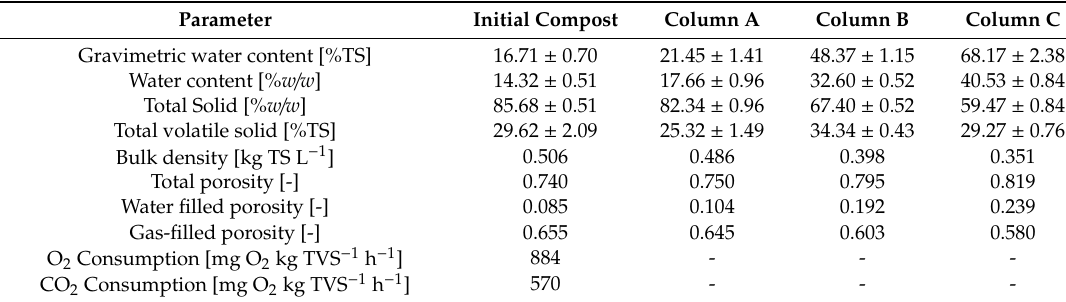
Table 1. Compost